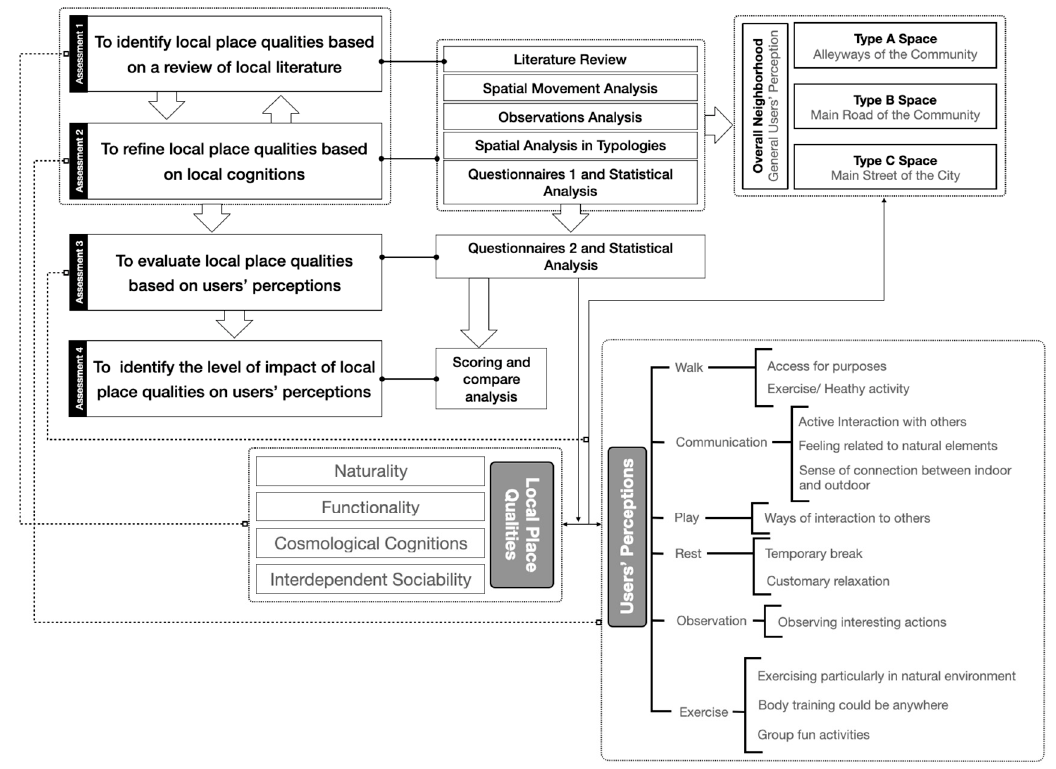
Figure 1. The research strategies of the study.